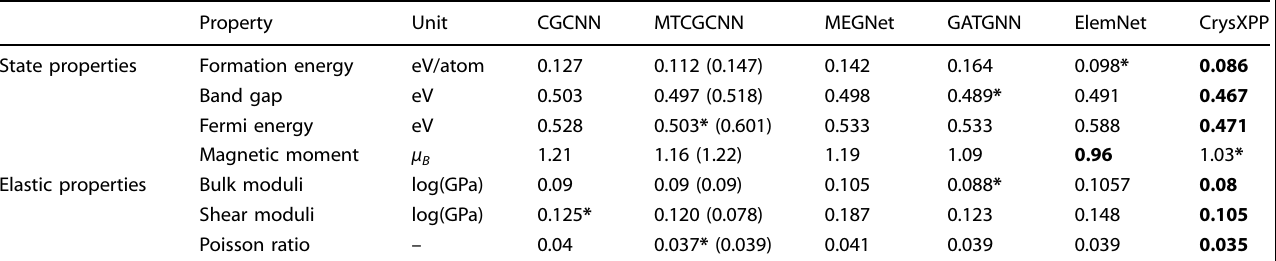
Table 2. Summary of the prediction performance (MAE) of different properties trained on 20% data and evaluated on 80% of the data. The best performance is highlighted in bold and second-best with * . We report MAE jointly training most correlated property (average on all property pairs) for